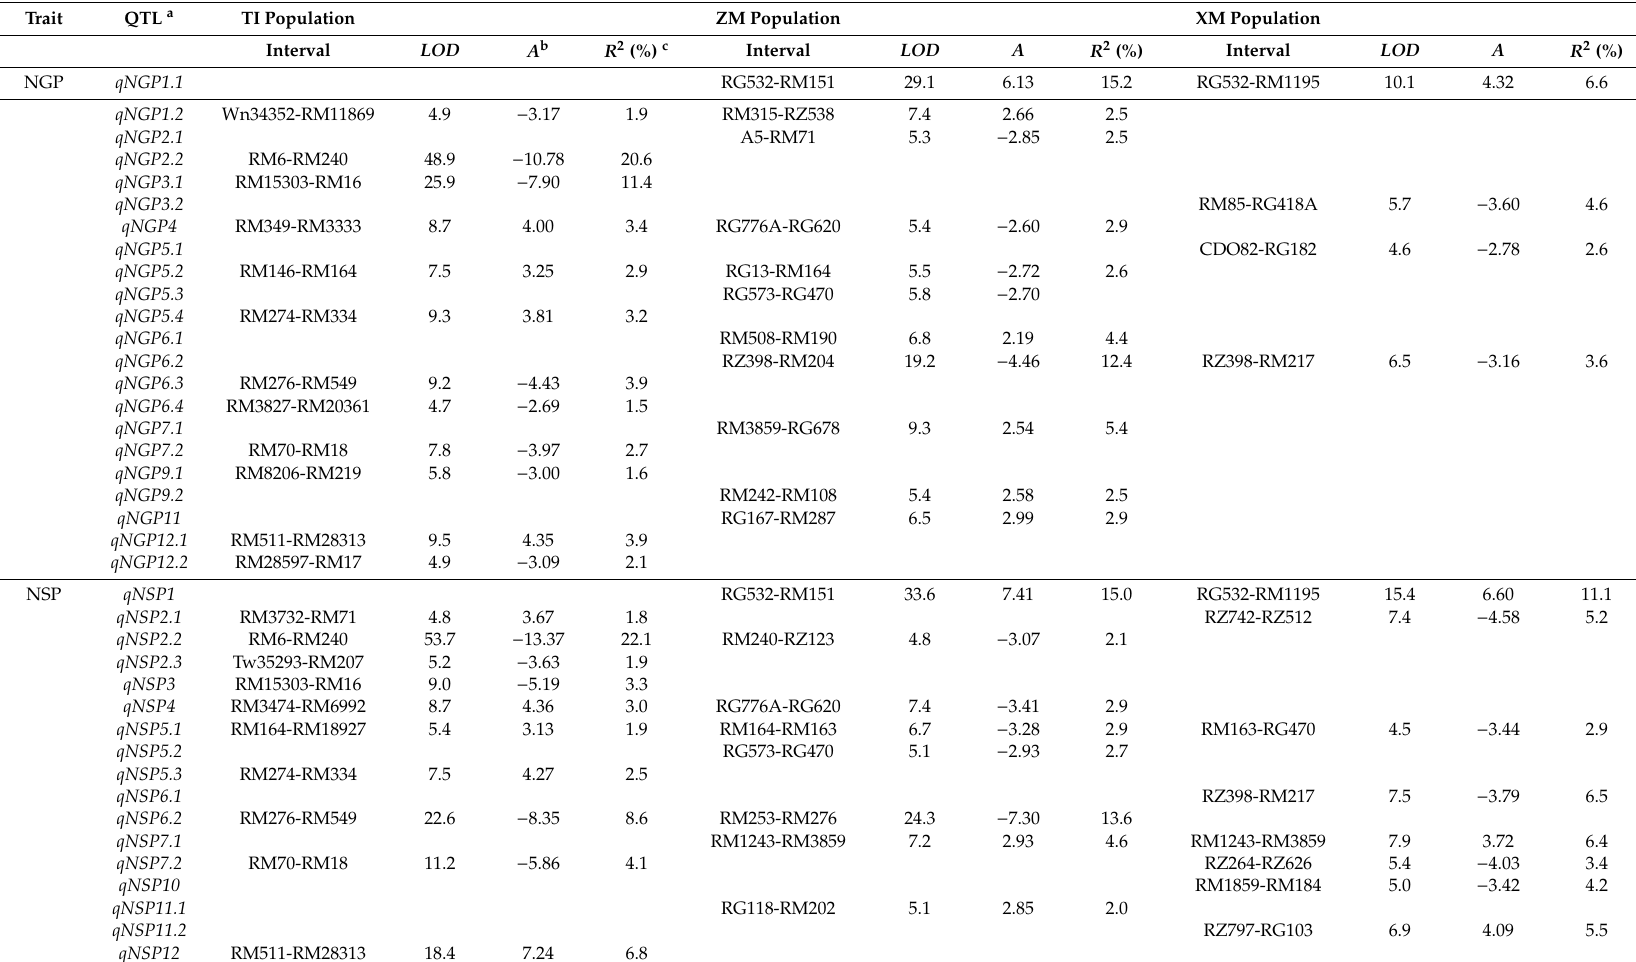
Table 2. Quantitative trait locus (QTLs) detected for NGP, NSP, and SF in three RIL